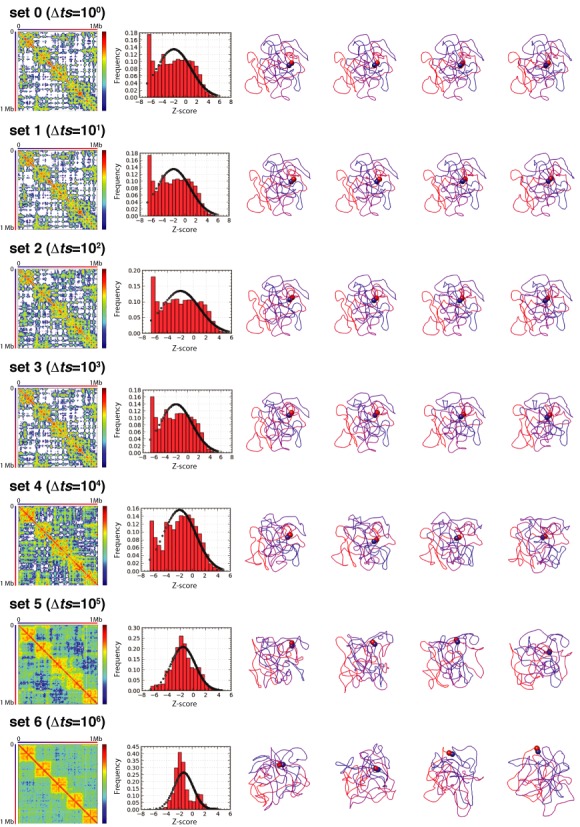
Simulated Hi-C interaction matrices. Simulated Hi-C interaction matrices for the toy genome architecture of chr75_TAD with noise levels α = 50. Each row shows the calculated matrix, the distribution of Z-scores and four randomly selected input structures, which are colored from particle 1 in blue to particle N in red, the start and end particles are highlighted with spheres. From top to bottom the figure depicts the simulated matrices from sets 0 to 6 (\documentclass[12pt]{minimal}
\usepackage{amsmath}
\usepackage{wasysym}
\usepackage{amsfonts}
\usepackage{amssymb}
\usepackage{amsbsy}
\usepackage{upgreek}
\usepackage{mathrsfs}
\setlength{\oddsidemargin}{-69pt}
\begin{document}
}{}$\Delta t = 1\;{\rm to}\;\Delta t = 1\;000\;000$\end{document}).